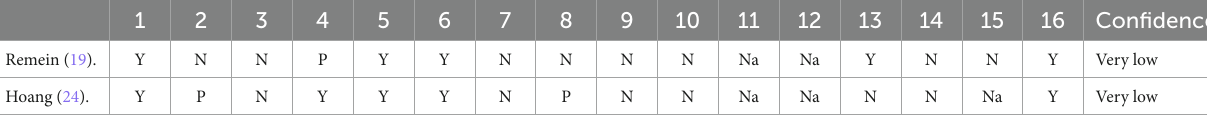
Ousager (18). + +/ − +/ − + Haidet (21). + + +/ − +/ − Carr (20). + + + + High Argawal (22). +/ − + + +/ − Perry (23). + + +